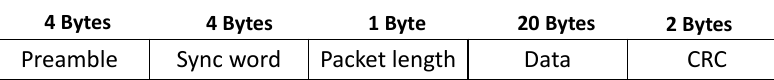
Figure 11. Google satellite image of the field measurement setup in the urban area. 3.2.3. Experimental Results Figure 12 shows the results of the measurements done in the urban and suburban areas. From these measurement results, it can be seen that increasing the bandwidth, 𝐵 , in the urban area to